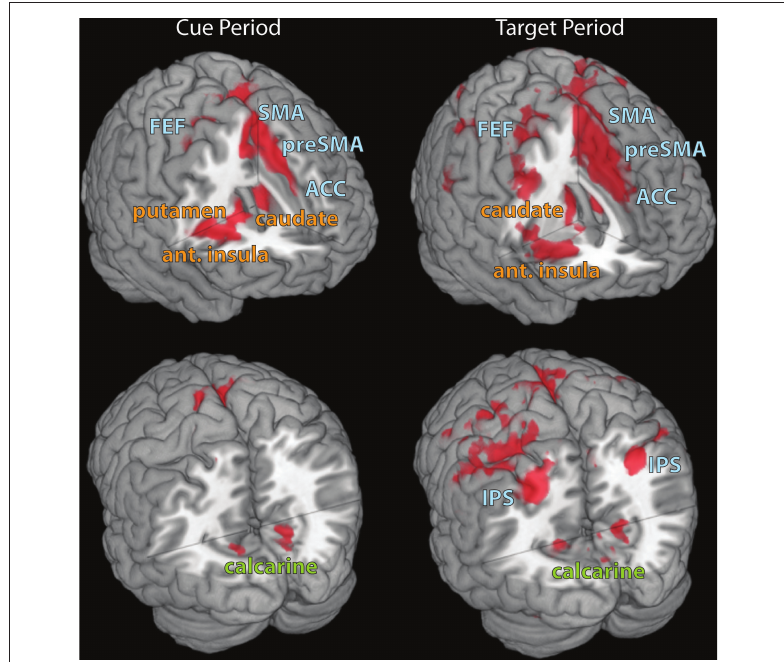
Figure  | Brain regions exhibiting correlations with absolute incentive magnitude during the cue and target task periods. Some of the attentional (blue font), visual (light green), and valuation (orange) regions are illustrated. ACC, anterior cingulate cortex; FEF, frontal eye field; IPS, intraparietal sulcus; pre-SMA, pre-supplementary motor area; and preSMA, pre-supplementary motor